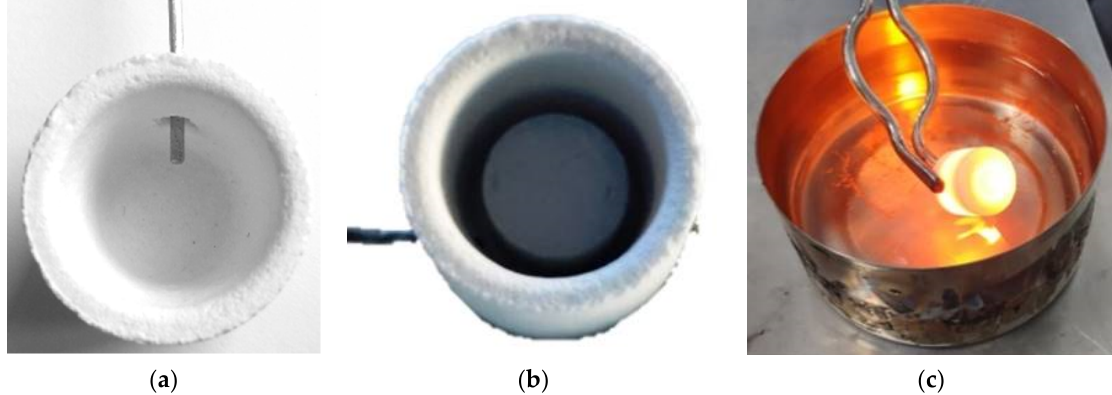
Figure 2. View of crucible with, ( a ) thermocouple insertion, ( b ) initial sample disk, and ( c ) quenching into cold water after treatment.